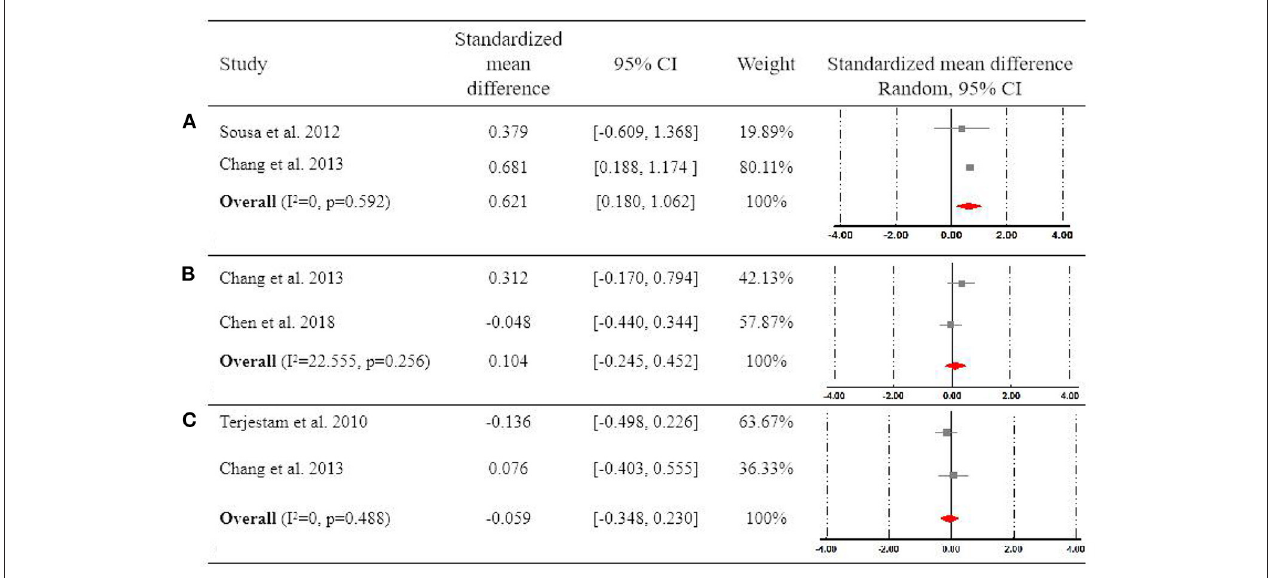
FIGURE 3 | Forest plot for meta-analysis regarding the effect of Qigong on (A) saliva cortisol level, (B) mood, and (C) self-esteem.